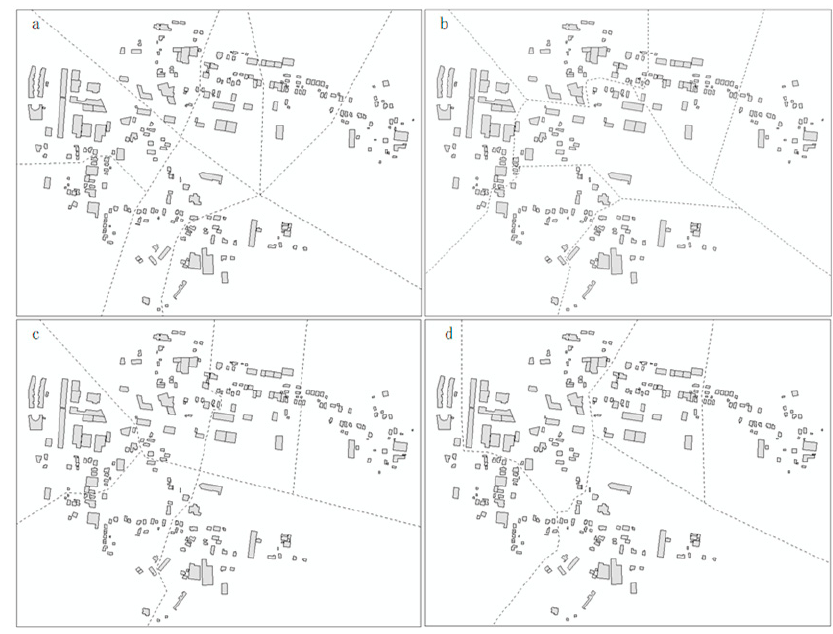
Figure 8. Clustering results in experimental region a .